Question: In a single sentence, describe what this figure presents.
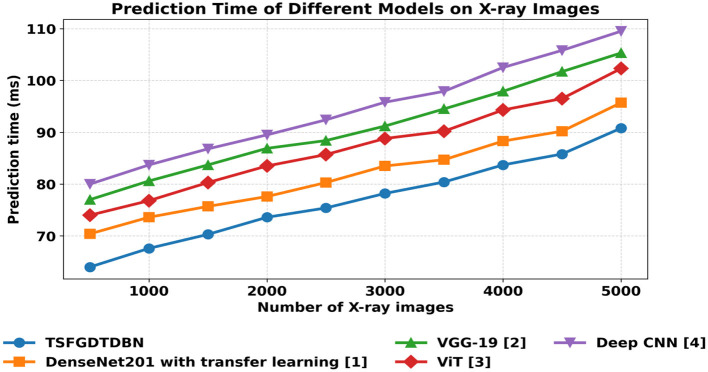
Answer: Performance analysis of prediction time using Multi-Class Knee Osteoporosis X-ray Dataset.